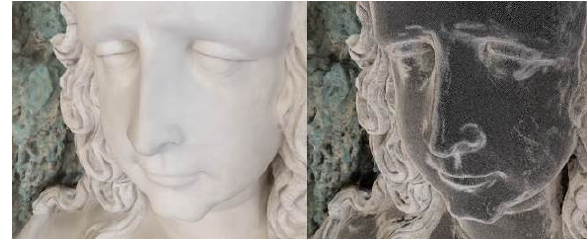
Figure 21. Detail of the statue model represented by textured faces (left) and by edges (right)